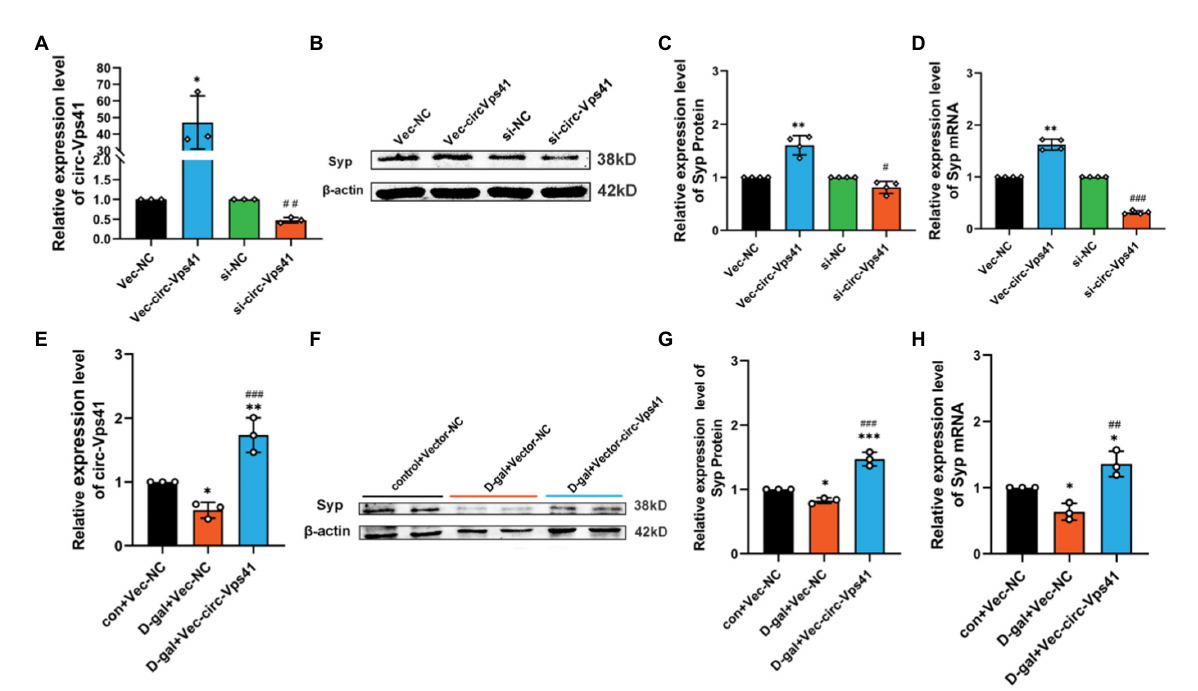
FIGURE 3 circ-Vps41 regulates the expression of Syp in vitro (A) The knockdown and overexpression efficiency of circ-Vps41 were measured by qRT–PCR in HT22 cells. (B,C) Representative images and quantification of Syp in HT22 cells after knockdown and overexpression of circ-Vps41 were tested by western blot. (D) The expression level of Syp mRNA was tested by qRT-PCR in HT22 cells after knockdown and overexpression of circ-Vps41. * p < 0.05, ** p < 0.01, *** p < 0.001 vs. Vec-NC group; # p < 0.05, ## p < 0.01, ### p < 0.001 vs. si-NC group. (E) The expression level of circ-Vps41 was tested by qRT–PCR after the overexpression of circ-Vps41 in D-galactose-induced aging HT22 cells. (F,G) Representative images and quantification of Syp after the overexpression of circ-Vps41 in D-galactose-induced aging HT22 cells were tested by western blot. (H) The expression level of Syp mRNA was tested by qRT-PCR after the overexpression of circ-Vps41 in D-galactose-induced aging HT22 cells. * p < 0.05, ** p < 0.01, *** p < 0.001 vs. con + Vec-NC group; # p < 0.05, ## p < 0.01, ### p < 0.001 vs. D-gal + Vec-NC group. Data are shown as the mean ± SEM. p values, two-tailed t -test, one- way ANOVA. The controls group were normalized to